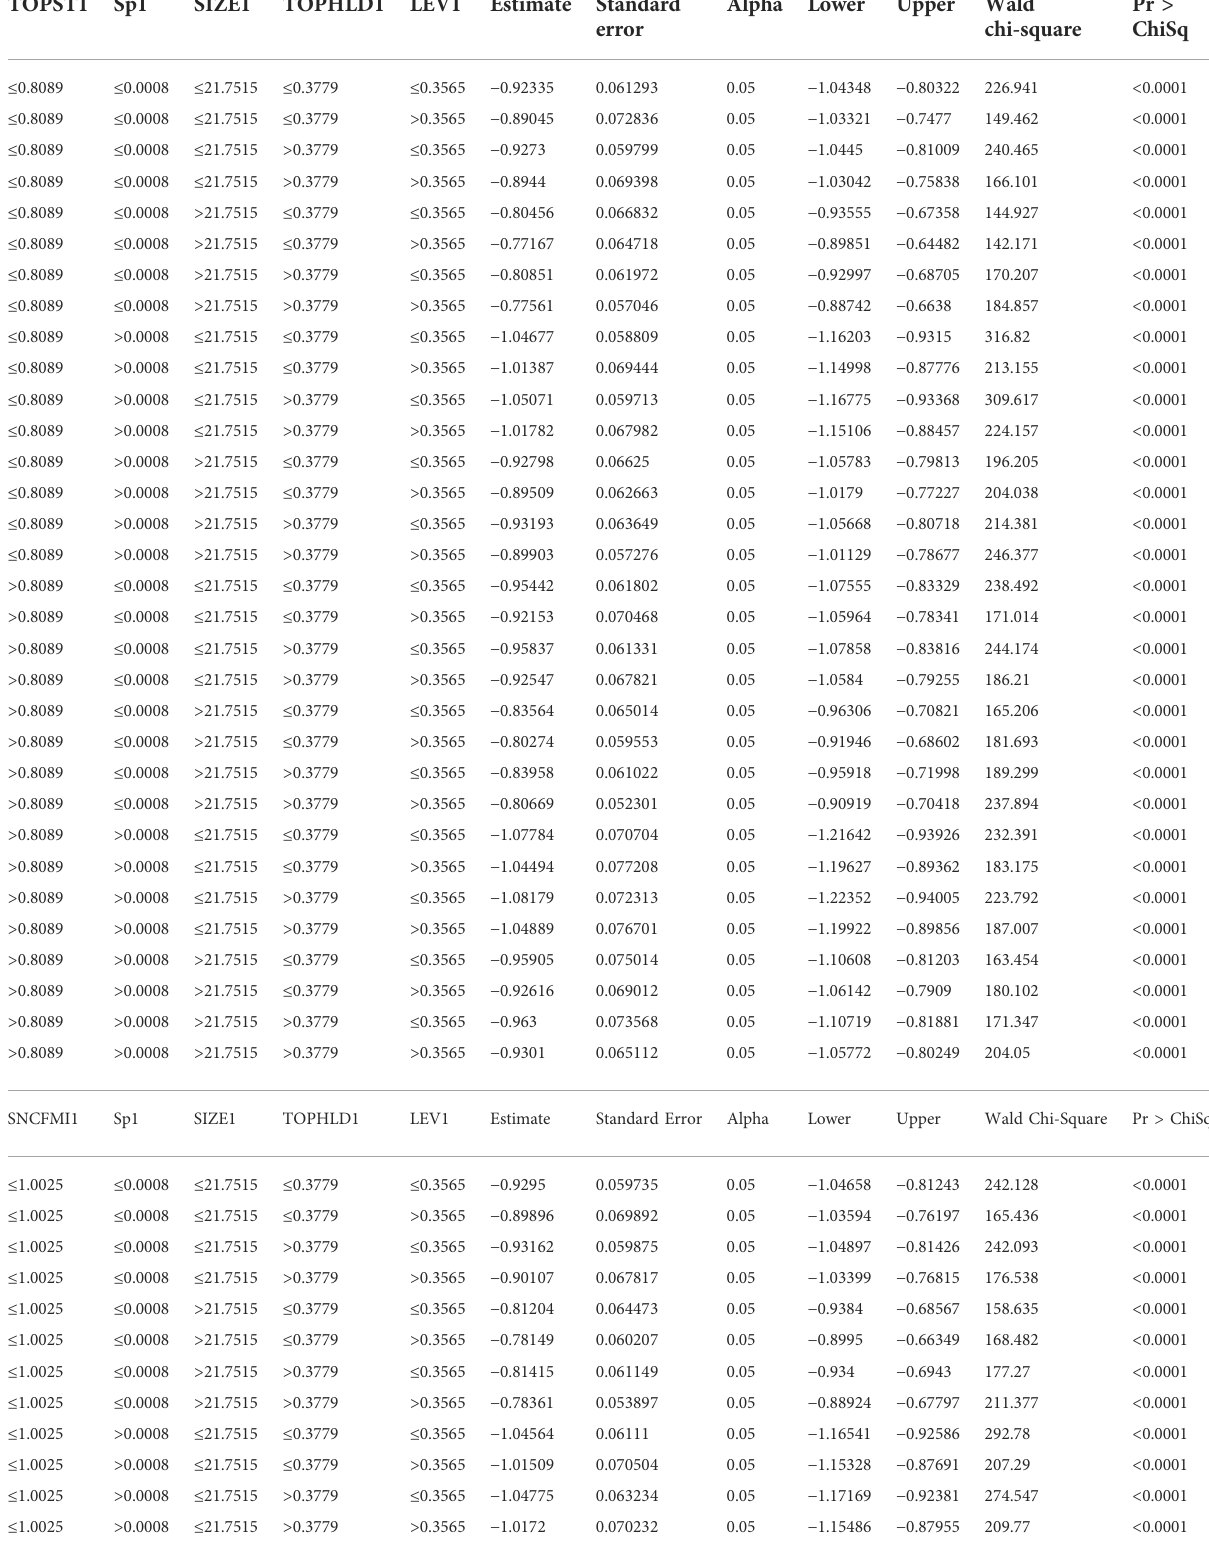
TABLE 7 Marginal effect analysis of SYNCH t+1 in the PSM